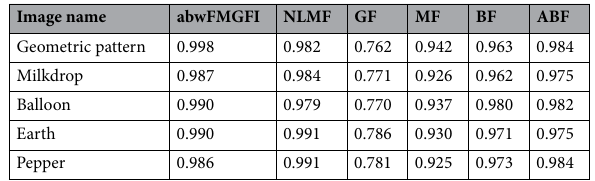
Table 12. Comparison of the SSIM values of each sample image filtered using each filter (regarding edge preservation